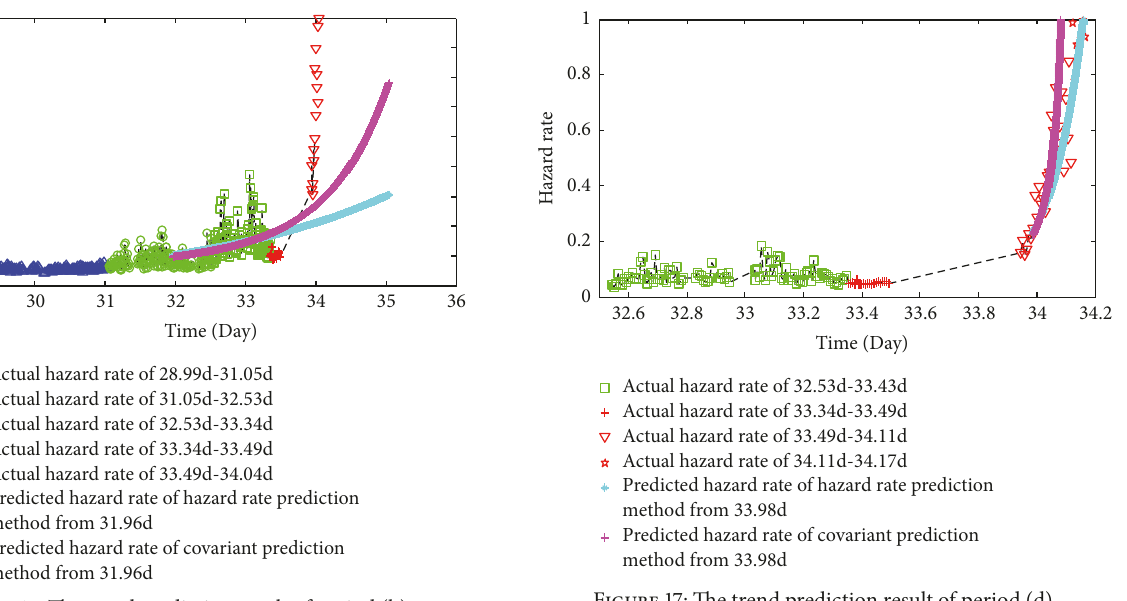
Figure 15: The trend prediction result of period (b).